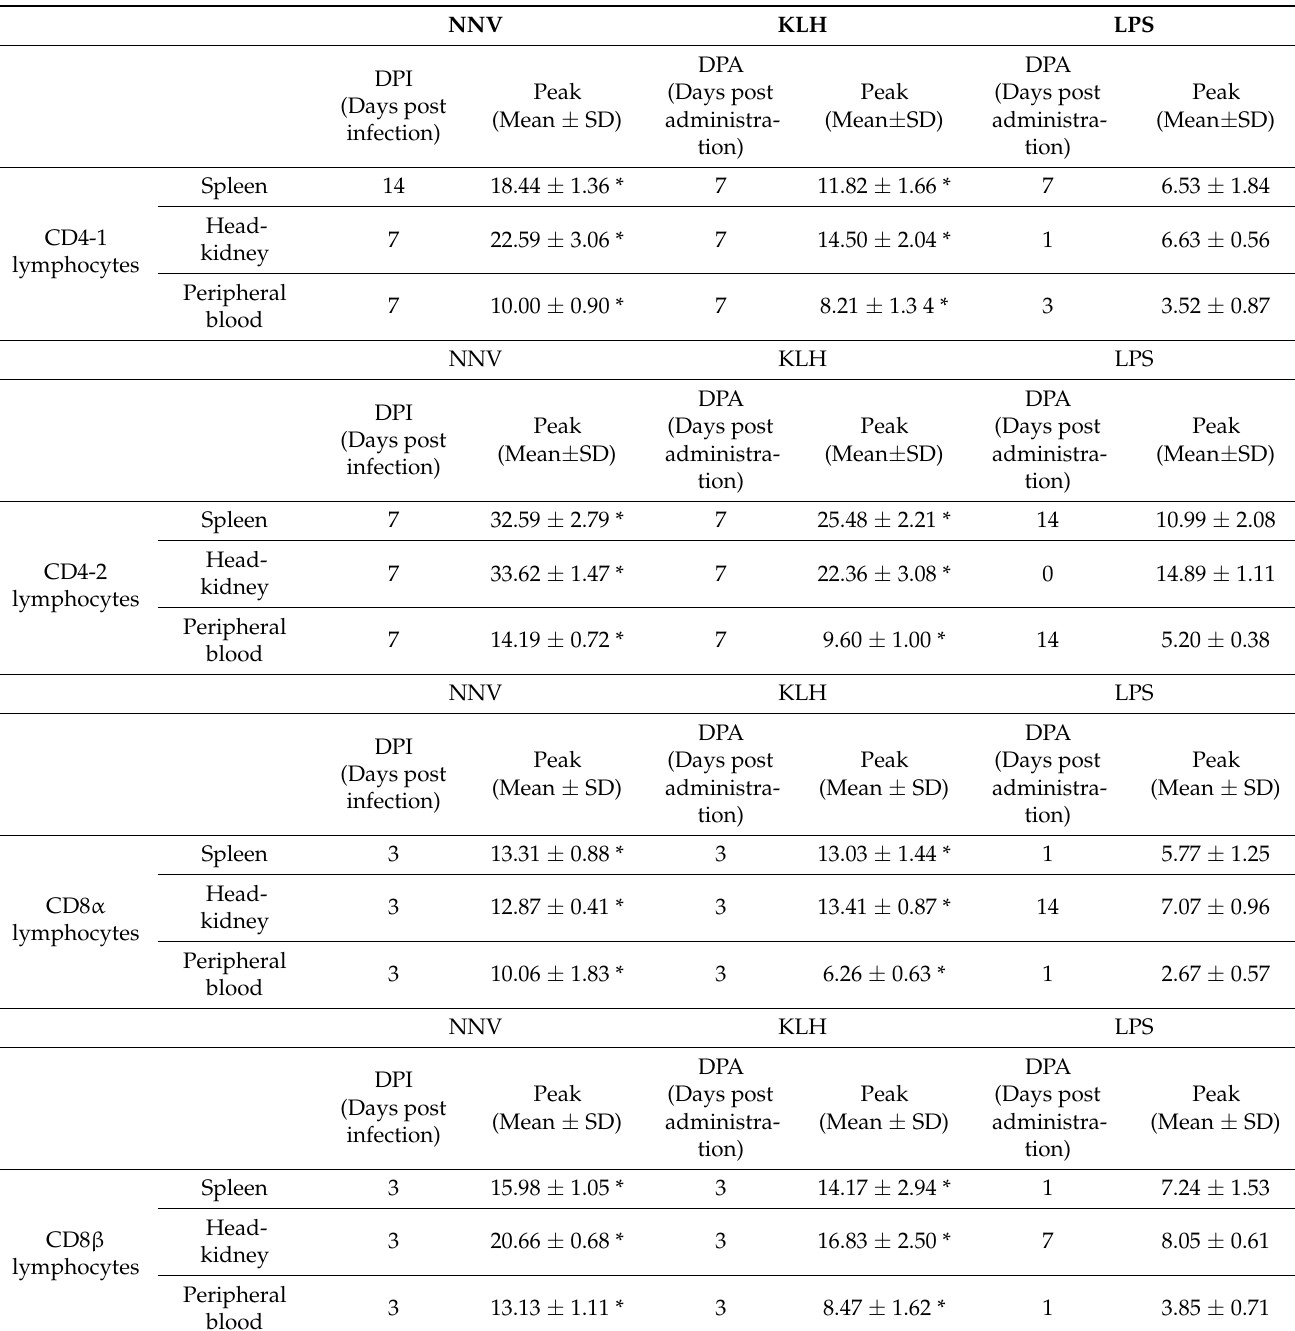
Table 5. The peak values of CD4-1, CD4-2, CD8 α and CD8 β lymphocytes after nervous necrosis virus (NNV), keyhole limpet hemocyanin (KLH) and lipopolysaccharide (LPS)